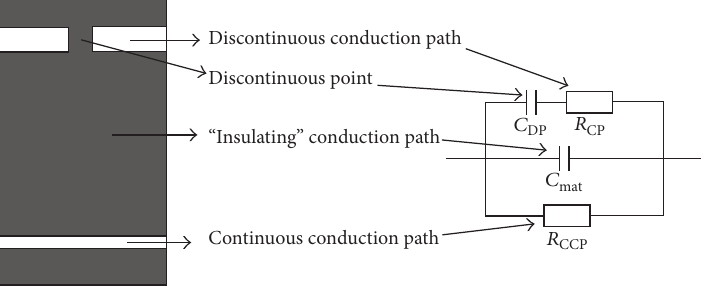
Figure 1: Concrete mesostructure for AC conducting.